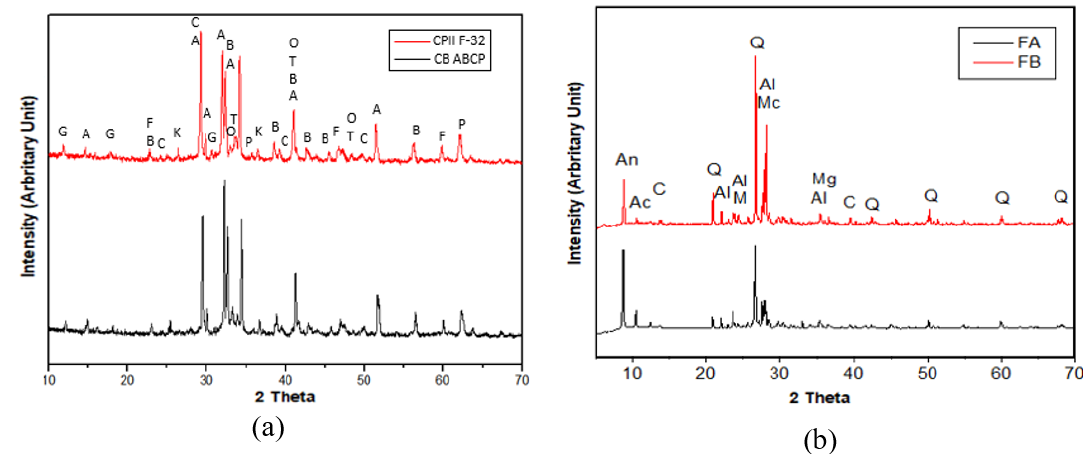
Figure 2. Identification of the crystalline phases of the (a) cements and (b) GRF studied. A-Alite; B-Belite; F-C 4 AF; T-cubic C 3 A, O-orthorambic C 3 A, C-Calcite, G-Gypsum, K-Arcanite, P-Periclase; Al-Albite; Q-Quartz; An- Annite; M-Microcline; Ac- Actinolite; Mg-Magnetite; C-Caulinite.